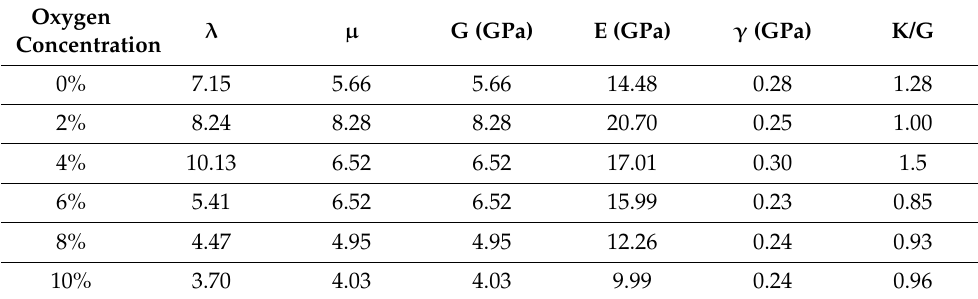
Table 6. Analysis of Mechanical Parameters.